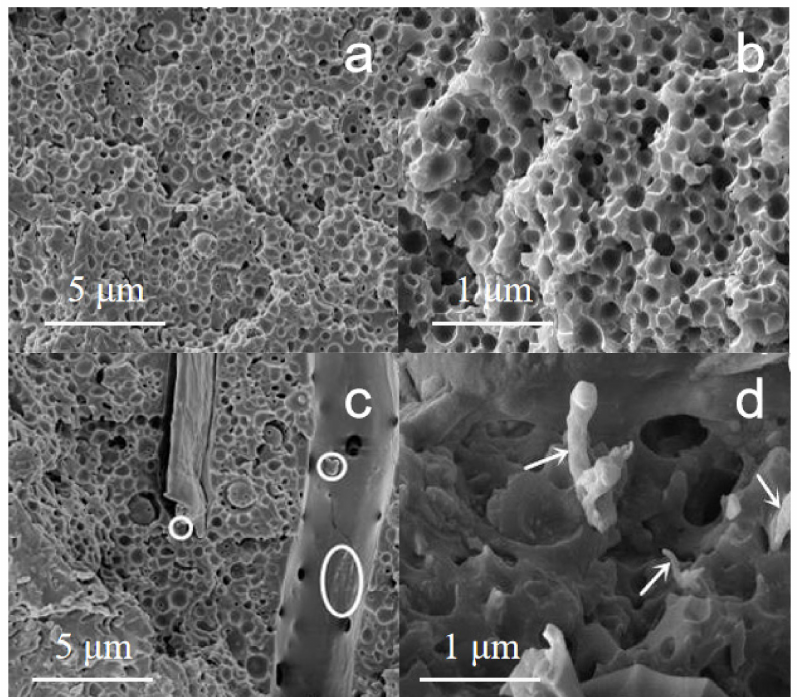
Figure 10. SEM images of the fractured surfaces of ( a , b ) neat epoxy membrane and ( c , d ) NCC- UPy/epoxy nanocomposite